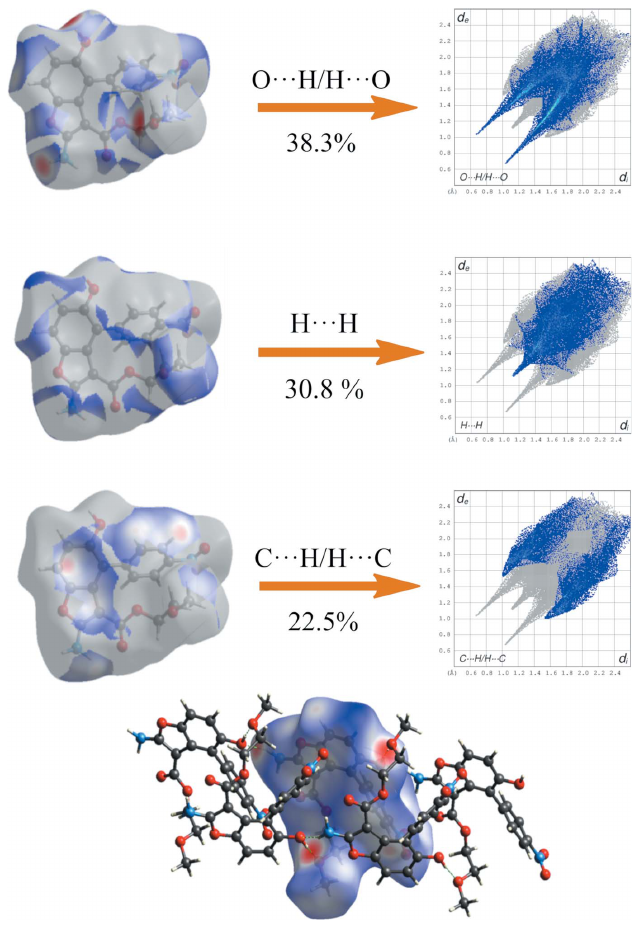
Figure 8 Two-dimensional fingerprint plots of significant intermolecular contacts for BF2 with the d norm surfaces indicating the relevant surface patch associated with the specific contact. The Hirshfeld surface mapped over d norm with strongly hydrogen-bonded molecules outside is